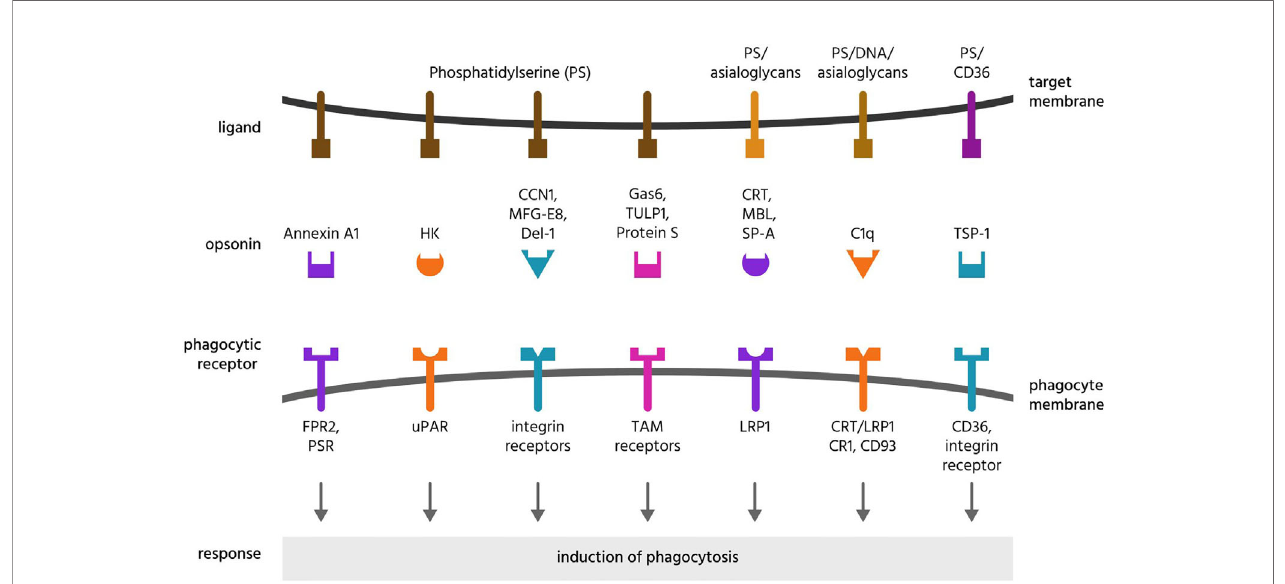
FIGURE 4 | Opsonins and their ligands and receptors. Opsonins are normally soluble, extracellular proteins, which when bound to target cells induce phagocytes to phagocytose these cells. To achieve this, most opsonins bind eat-me signals on the target cell and phagocytic receptors on the phagocyte, and these are illustrated here for a variety of opsonins that bind phosphatidylserine or asialoglycans. CCN1, cellular communication network factor 1; CD, cluster of differentiation; CR1, complement receptor 1; CRT, calreticulin; Del-1, developmental endothelial locus 1; DNA, deoxyribonucleic acid; FPR2, formyl peptide receptor 2; HK, high molecular weight kininogen; LRP1, lipoprotein receptor-related protein 1; MBL, mannose-binding lectin; MFG-E8, milk fat globule-epidermal growth factor E8; PS, phosphatidylserine; PSR, phosphatidylserine receptor; SP-A, surfactant protein A; TAM receptors, Tyro, Axl and MerTK receptors; TSP-1, thrombospondin 1;